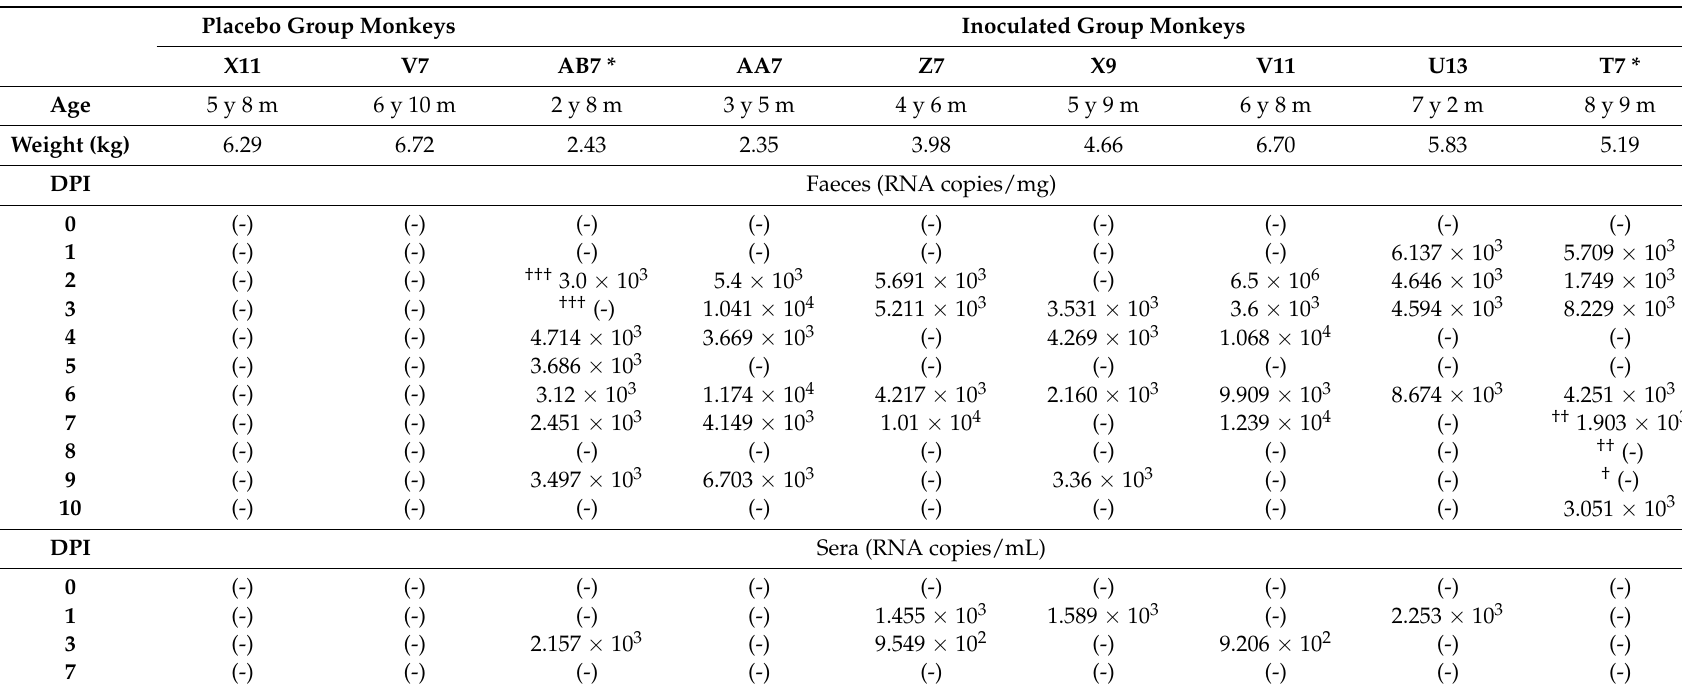
Table 1. Quantification of group A rotaviruses from faeces and sera of cynomolgus monkey by reverse transcription–real time polymerase chain reaction. Placebo Group Monkeys Inoculated Group